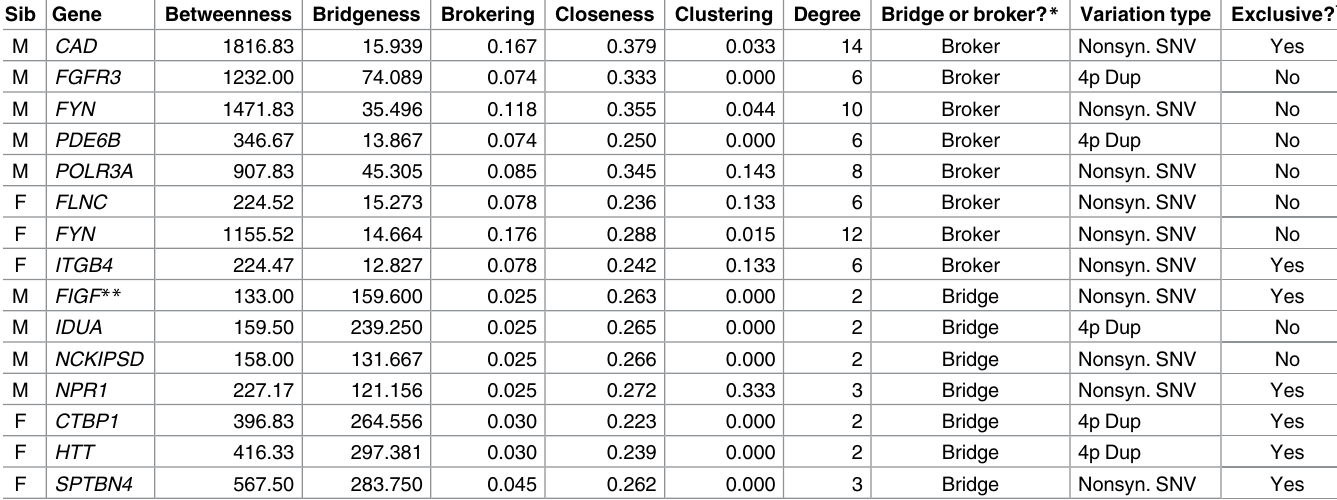
Table 3. Comparison of broker and bridge genes in the biggest connected components of the networks of the two siblings. Sib Gene Betweenness Bridgeness Brokering Closeness Clustering Degree Bridge or broker? * Variation type Exclusive?